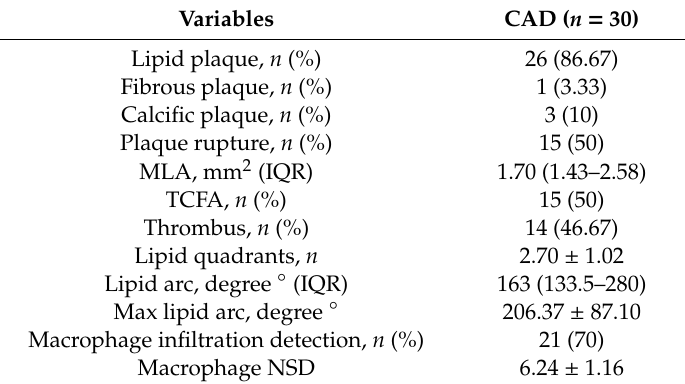
Table 2. Optical coherence tomography features of coronary plaque in CAD